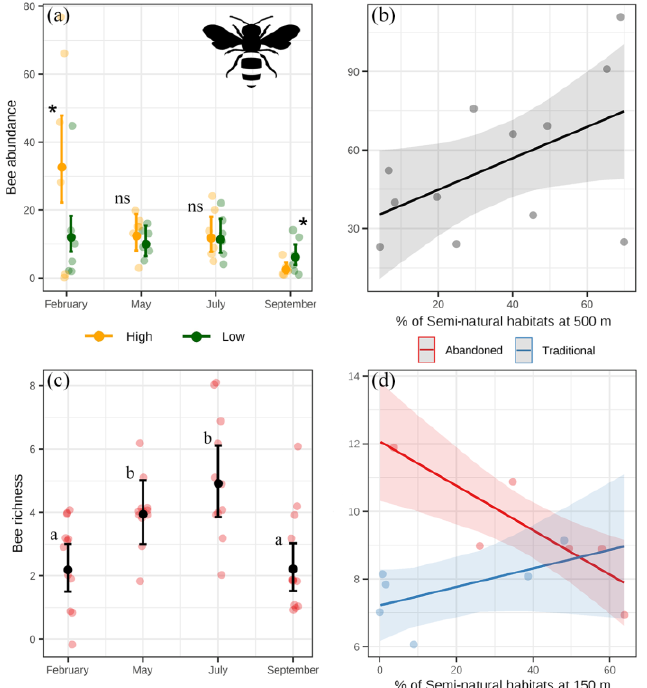
Figure 6. Results of the linear models for bee abundance ( a , b ) and richness ( c , d ). Points with error bars represent estimated means and 95% confidence intervals from the models’ predictions, and dull dots represent the raw data. Significant differences ( p < 0.05) are shown with asterisks. Significant differences ( p < 0.05) in pairwise comparisons are shown with different letters. ns: not significant.